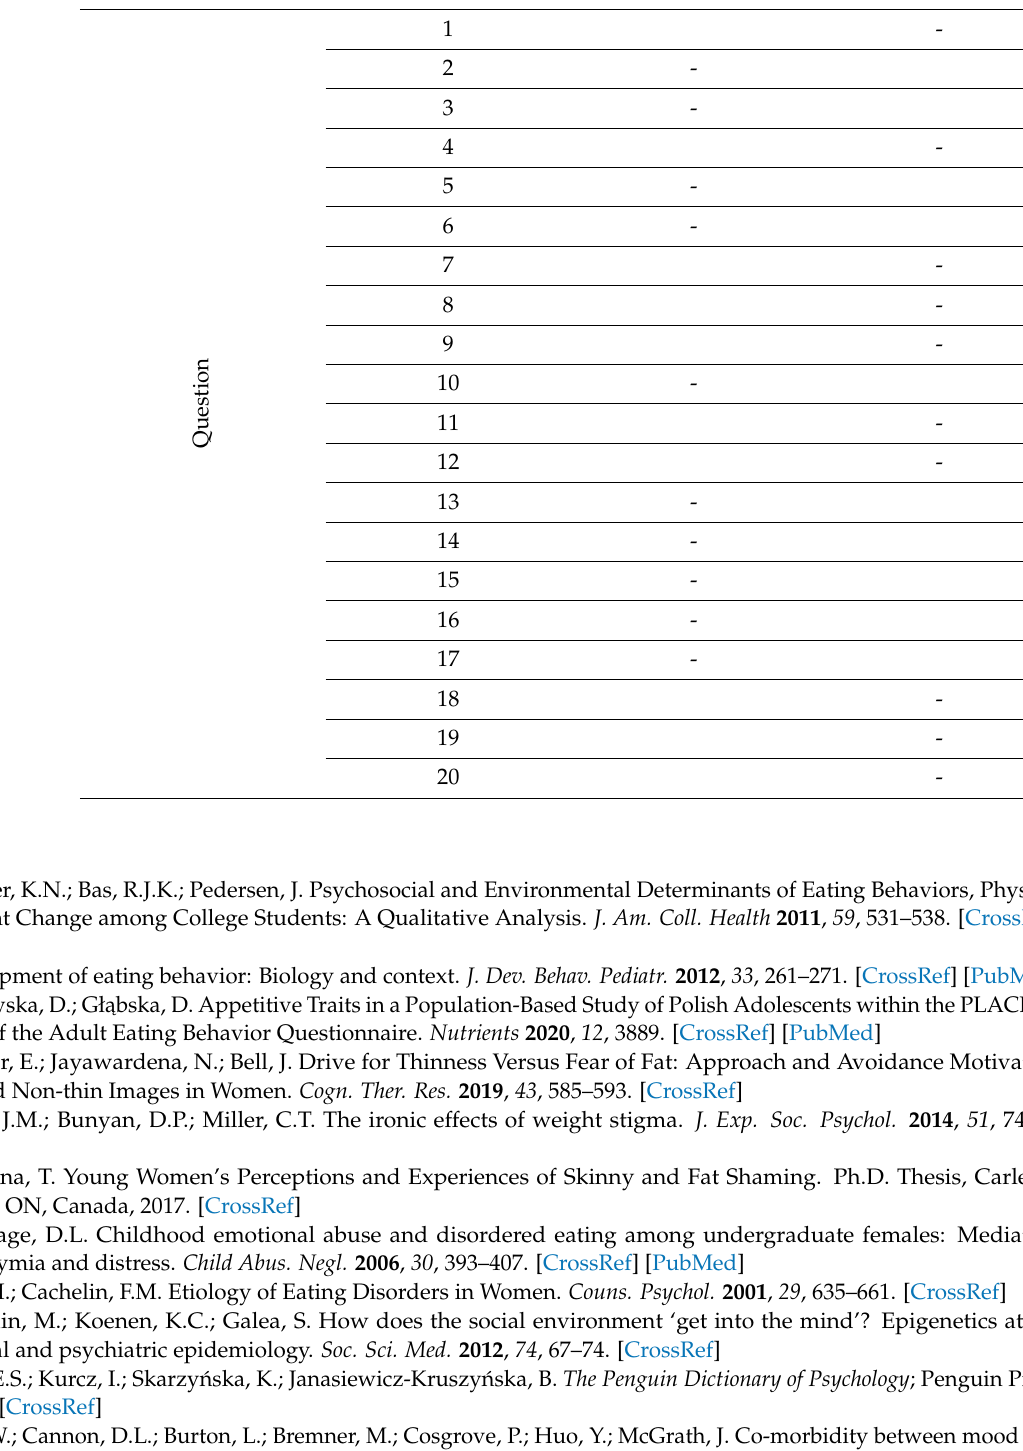
Table A3. Method of calculating the results. Score AGF ALW (Sum of